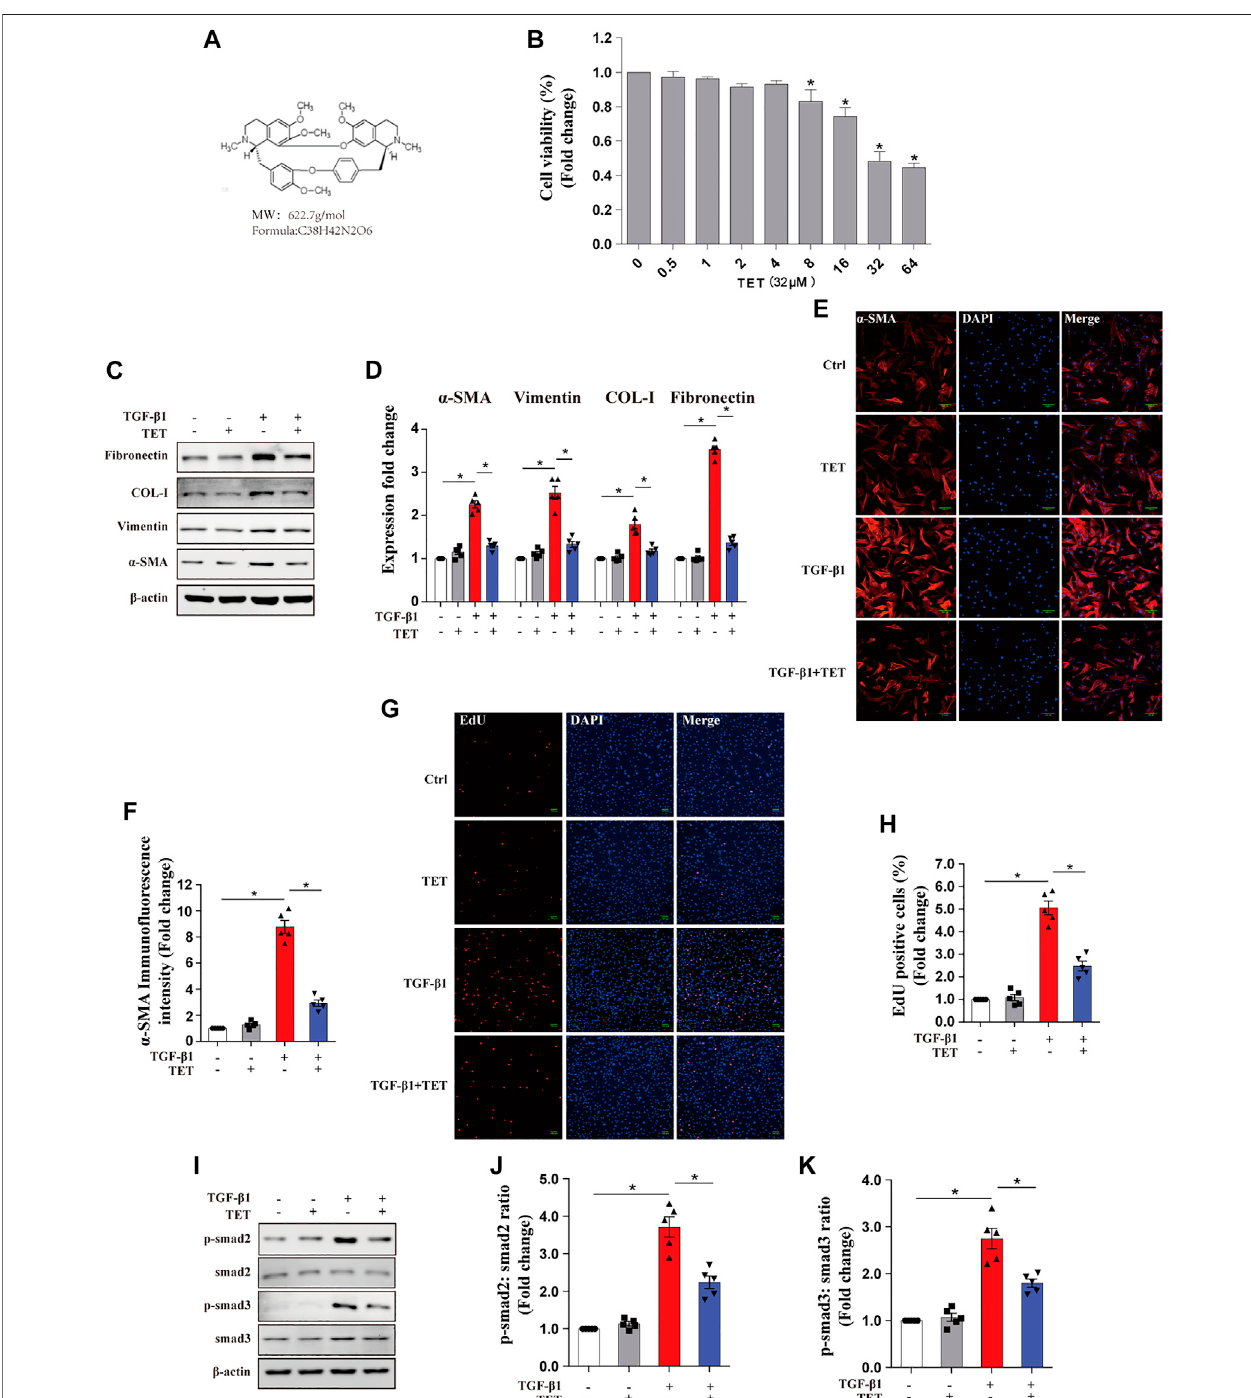
FIGURE 1 | Tetrandrine suppresses TGF- β 1-induced myo fi broblasts differentiation, proliferation, and ECM deposition in primary MLFs. (A) Chemical structure of TET. Its Molecular formation is C 38 H 42 N 2 O 6 . (B) Primary MLFs were incubated with various indicated concentrations of TET for 24 h and subjected to CCK8 assay to assess cell viability. One-way ANOVA with Dunnett ’ s multiple comparison test: * p < 0.05 comparison to TET (cid:2) 0 μ M group value: * p < 0.05. (C,D) Primary MLFs were pretreated with DMSO or TET (4 μ M) for 1 h and stimulated with or without TGF- β 1 (10 ng/ml) for 24 h. Representative immunoblot analysis (C) and quantitative analysis (D) show the expression of ECM deposition ( fi bronectin, COL-I), myo fi broblasts transdifferentiation (vimentin, α -SMA). (E,F) Representative Immuno fl uorescence monitored by confocal microscopy (E) and quantitative analysis (F) show the expression of α -SMA (red) in Primary MLFs. Blue staining indicates nuclei Scale bars: 100 μ M. (G,H) Representative Immuno fl uorescence (G) and quantitative analysis (H) of EdU -positive cell proportion show the proliferation marker ( EdU: 5-ehtynal-2 ′ -deoxyuridine) inmyo fi broblast.Scalebars:100 μ M. (I-K) Representativeimmunoblotanalysis (I) andquantitativeanalysis (J,K) showtheexpression of TGF- β /smad pathway markers (p-smad2, smad2, p-smad3, smad3) in primary MLFs. p values were determined by two-way ANOVA with Tukey ’ s multiple comparison test (n (cid:2) 5): * p < 0.05.